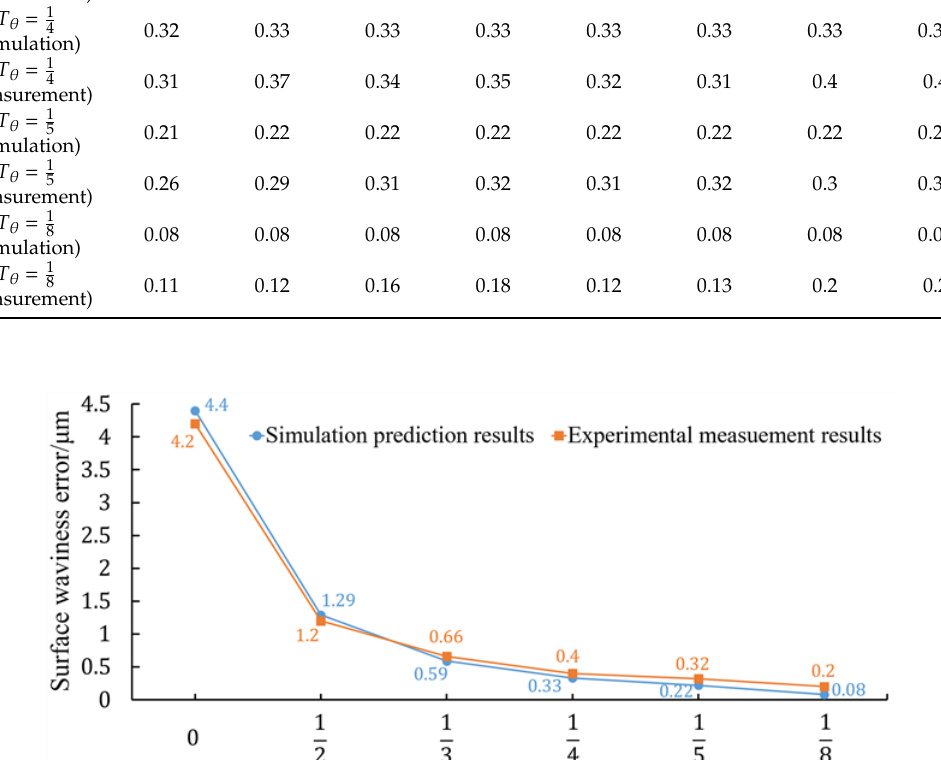
Figure 14. Analysis of the measured cross-section profile of the ground Fresnel micro-structured mold by a chromatic confocal displacement sensor. ( a ) evaluation of the corner radius of the 7 th valley corner; ( b ) evaluation of the corner radius of the 5 th valley corner; ( c ) evaluation of the corner radius of the 3 rd valley corner; ( d ) evaluation of the corner radius of the 1 st valley corner; ( e ) measurement result of the cross-section profile of the ground Fresnel micro-structured mold; ( f ) profile deviation analysis of the ground Fresnel micro-structured. 4. Conclusions Focusing on the surface waviness error of the Fresnel micro-structured mold machined by the parallel grinding process, this paper conducted theoretical modeling and experimental research and some conclusions could be drawn.